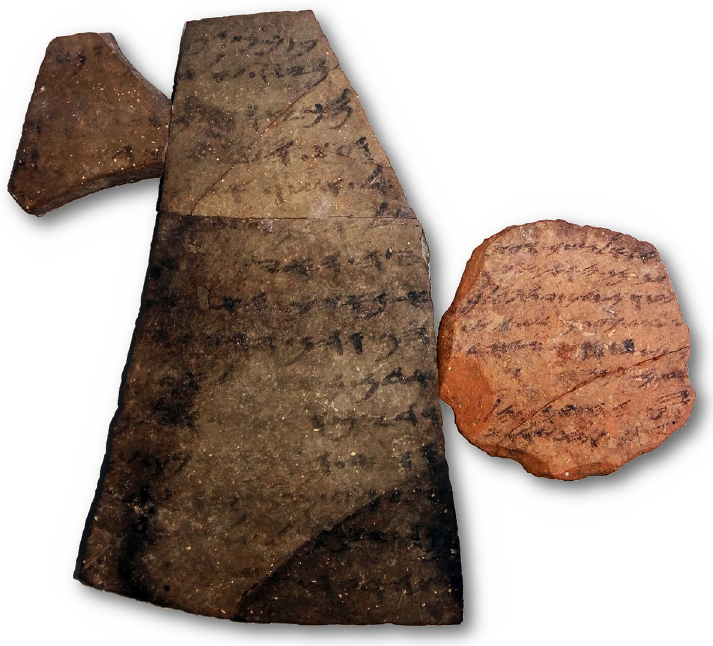
Fig 2. Examples of two Hebrew ostraca from Arad. Left: Ostracon 40 (9.5x14.6 cm), right: Ostracon 3 (6.0x5.9 cm). The poor state of preservation, including stains, cracks and blurred text, is apparent. The clay sherds are significantly different in shape, size, type of clay, and in their handwriting. Image courtesy of Yana Gerber and the Israel Antiquities Authority.